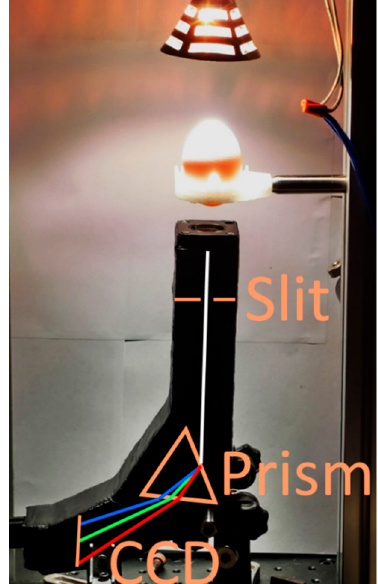
Figure 1. Spectrum experimental setup.